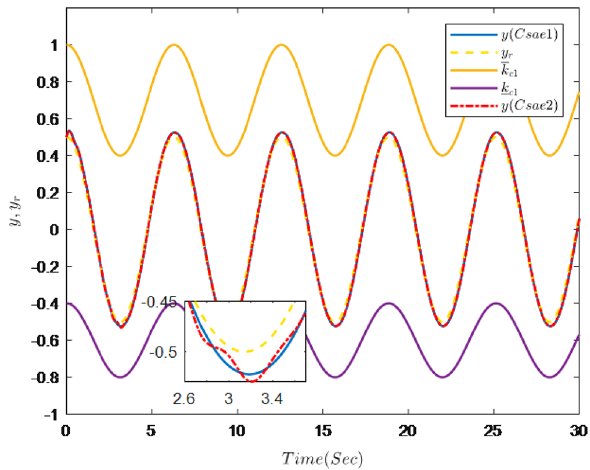
Figure 1. Trajectories of the output y , the reference signal y r and constraint